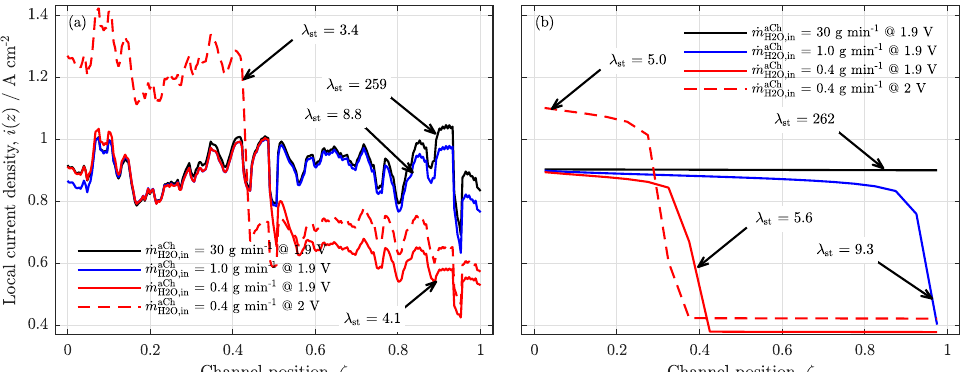
Figure 5. Current density distributions for different anode feed water flow rates; ( a ) results from the experimental study (data from Immerz et al. [5]), flow rates: 30gmin − 1 , black line; 1.0gmin − 1 blue line, 0.4gmin − 1 , red lines (full at 1.9V, dashed at 2.0V); and ( b ) model results with a right-bent coupling between the liquid phase ratios in the channel and the CLs for identical flow rates and voltages; temperature, T = 60°C; ambient cell pressure, p aCh = p cCh =